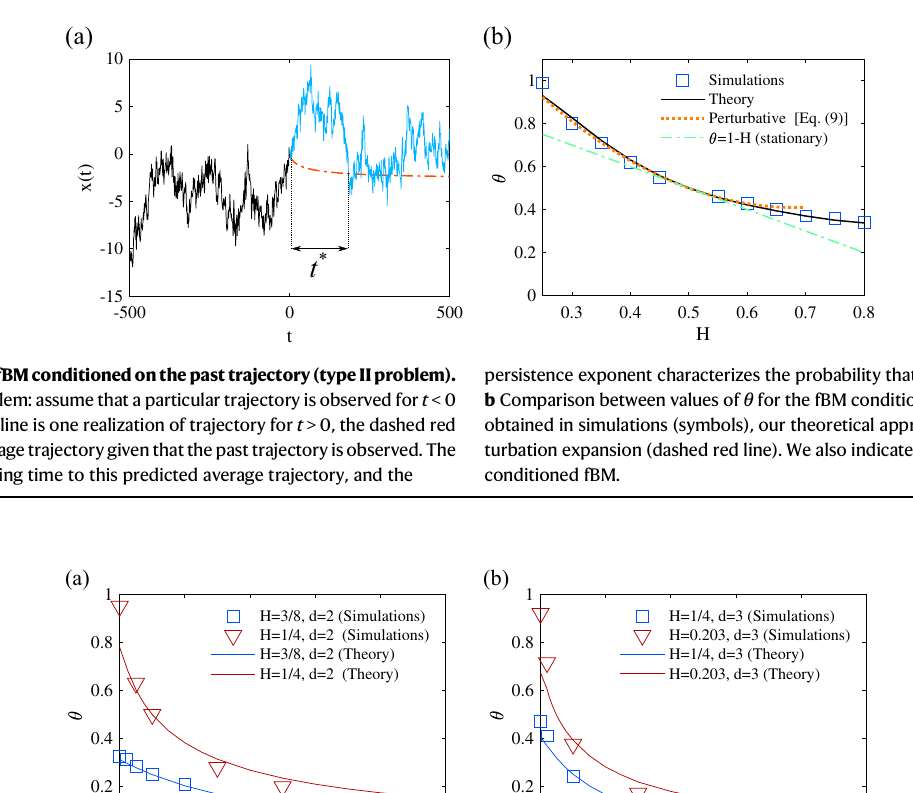
hydrodynamicinteractions( H =1/4),macromoleculeoffractalarchitecture(Vicsek fractal, H ≃